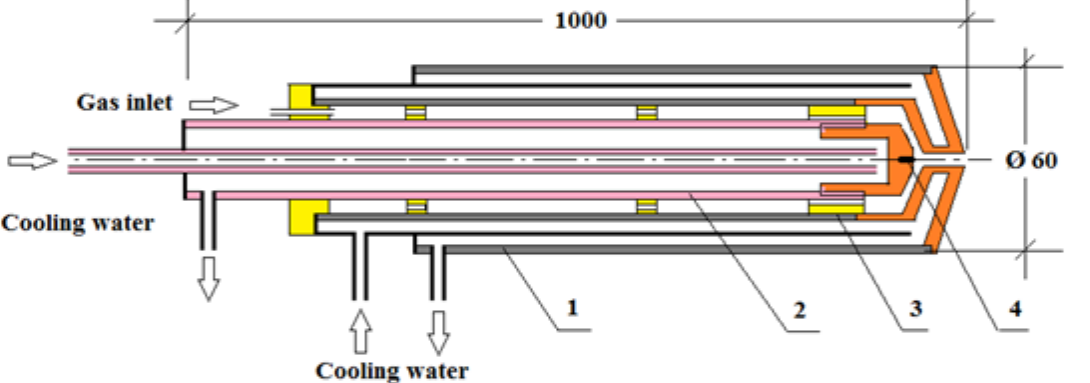
Figure 3. Schematic of the experimental plasma torch. 1—outside casing, 2—cathode holder, 3—insulating ring, 4—hafnium cathode.